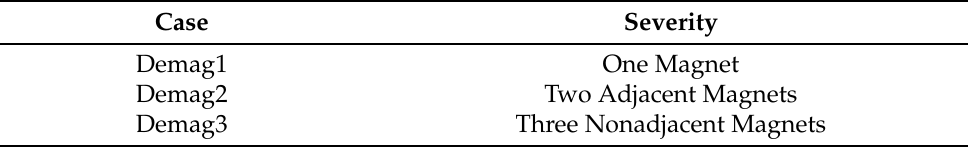
Table 5. Severity levels of demagnetization fault.